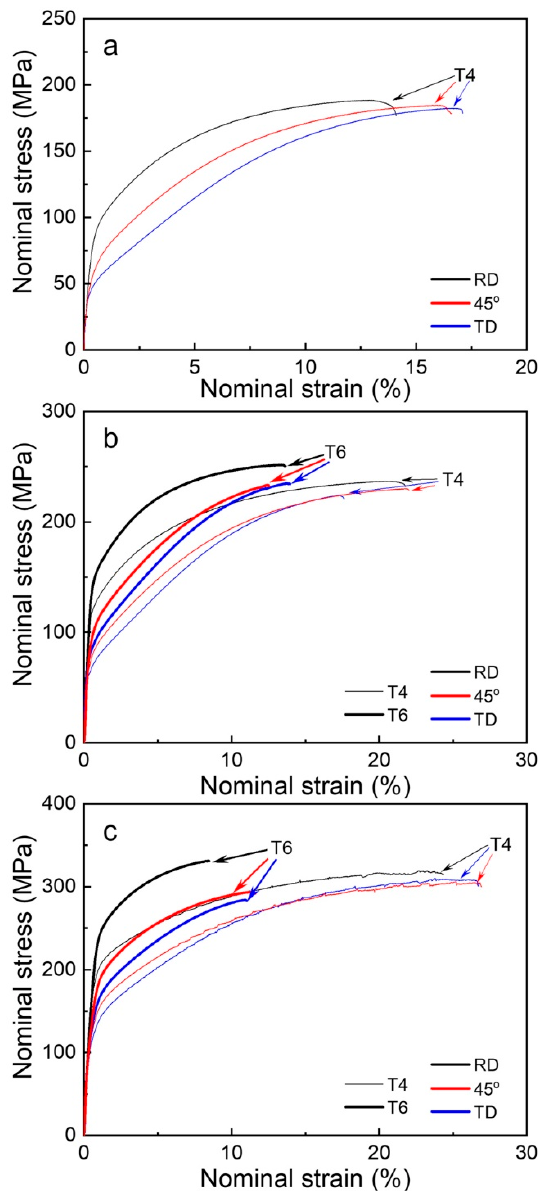
Figure 4. Tensile curves obtained from ( a ) T4 ‐ treated Mg–1.5Ag–0.1Ca alloy sheet, and T4 ‐ and T6 ‐ treated ( b ) Mg–6Ag–0.1Ca and ( c ) Mg–12Ag–0.1Ca alloy sheets along RD, 45° and TD at RT.